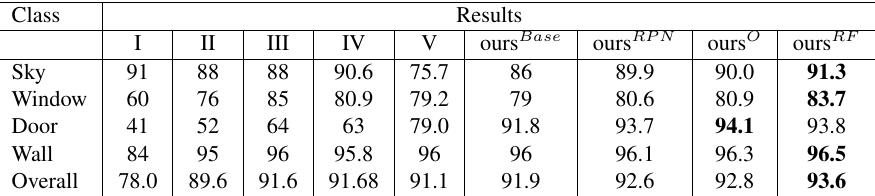
Table 1. Labeling results on dataset Graz of different methods (I-(Riemenschneider et al., 2012), II-(Cohen et al., 2014), III-(Cohen et al., 2017), IV-(Jampani et al., 2015), V-(Rahmani et al., 2017)), ours Base – Structured Random Forest (SRF) only, ours RPN – SRF with Region Proposal Network (RPN), ours O – SRF with optimization and ours RF – Rectangular Fitting applied to ours O . Best results given in bold.